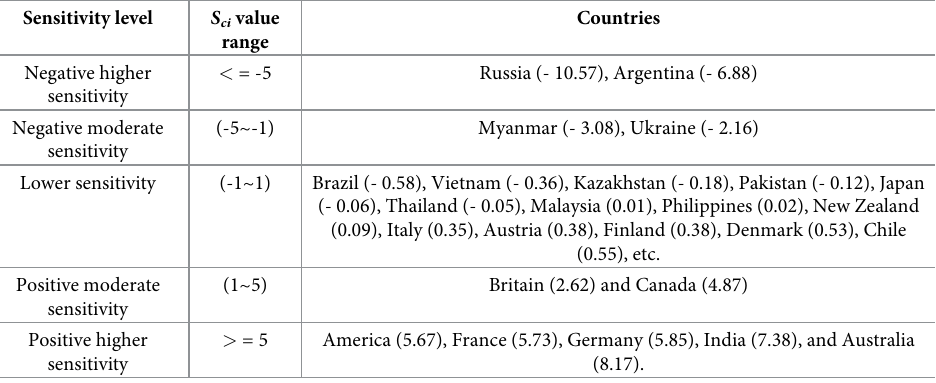
Table 4. Differences of China’s sensitivity to importing